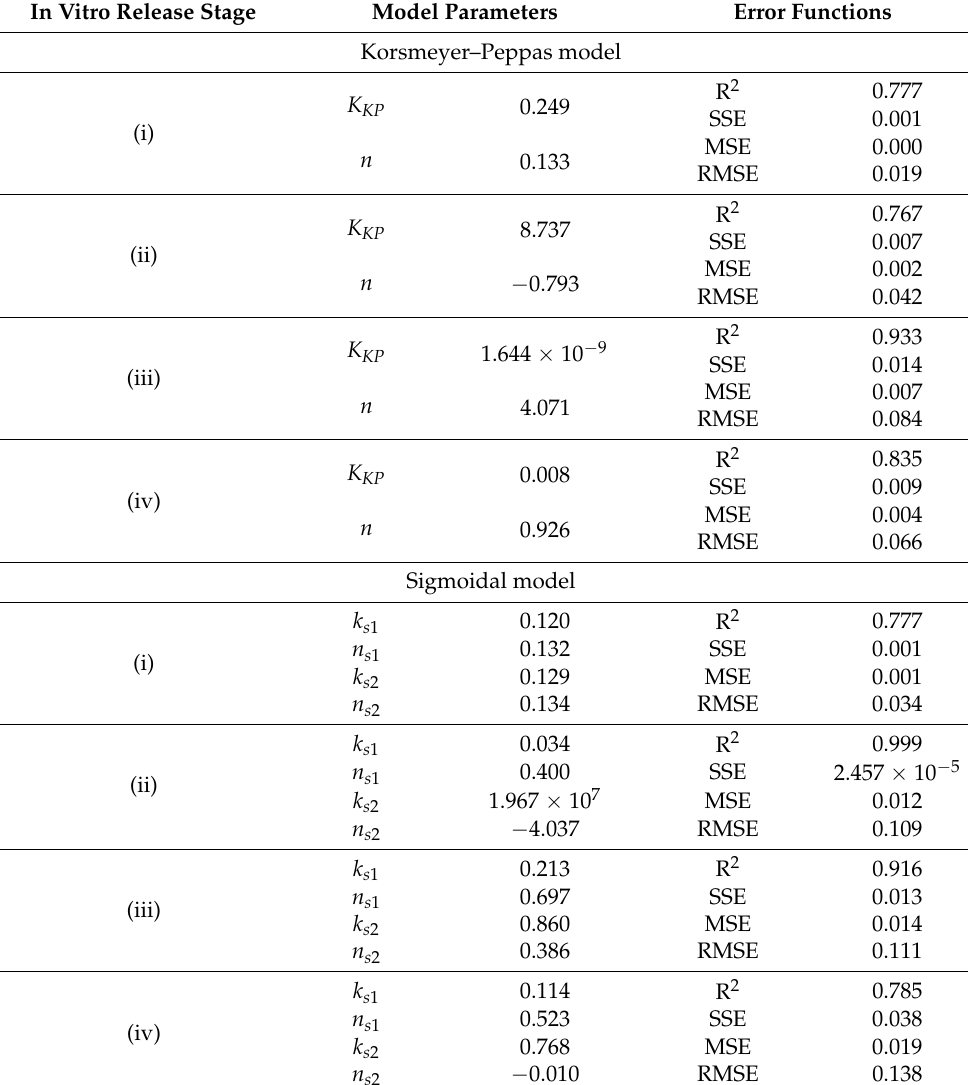
Table 2. Values of the model parameters, correlation coefficients and error functions of the applied in vitro release kinetics